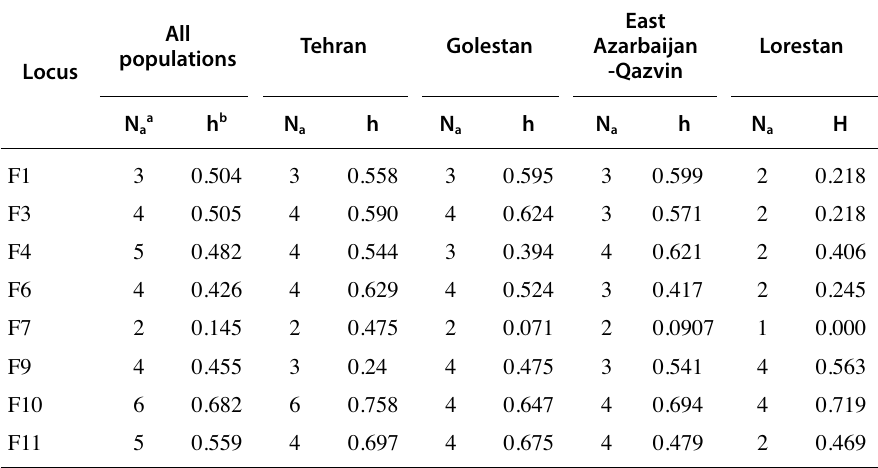
Table 2. Number of observed alleles and gene diversity of eight simple sequence repeat (SSR) markers among 88 isolates